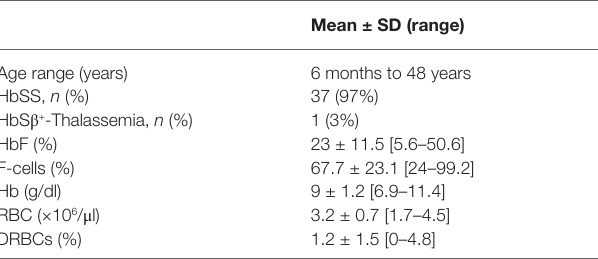
TABLE 1 | Characteristics of patients evaluated by oxygen-gradient